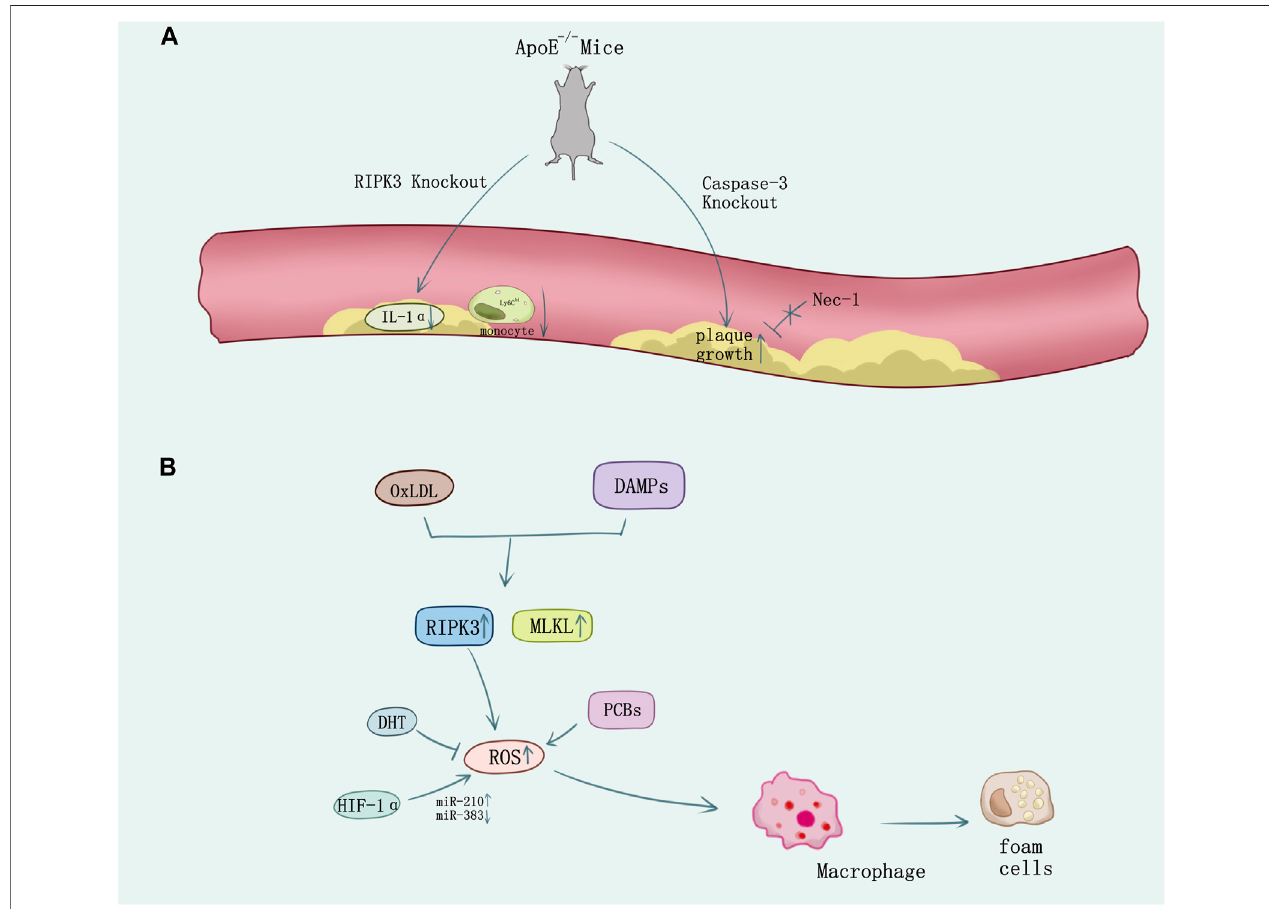
FIGURE 4 | The necroptosis in atherosclerosis. (A) In ApoE-knockout-induced spontaneousatherosclerosis mice, knock out RIPK3 causesthe decrease of IL-1 α and the Ly6C hi monocyte. However, knock out the caspase-3 causes the plaque growth which cannot be reversed by the inhibitor of RIPK1 Nec-1. (B) Ox-LDL or DAMPs stimulation released from necrotic cells induces necroptosis in macrophage and the formation of foam cells. ROS overproduction promotes necroptosis which can besuppressed byoxidative stressinhibition using DHT. HIF-1 α promotes macrophage necroptosis and ROSproduction byregulatingmiR-210 and miR-383.